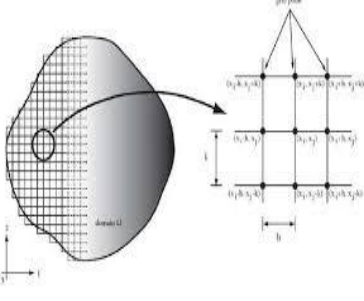
Figure 2: Finite Difference Grid in 2D